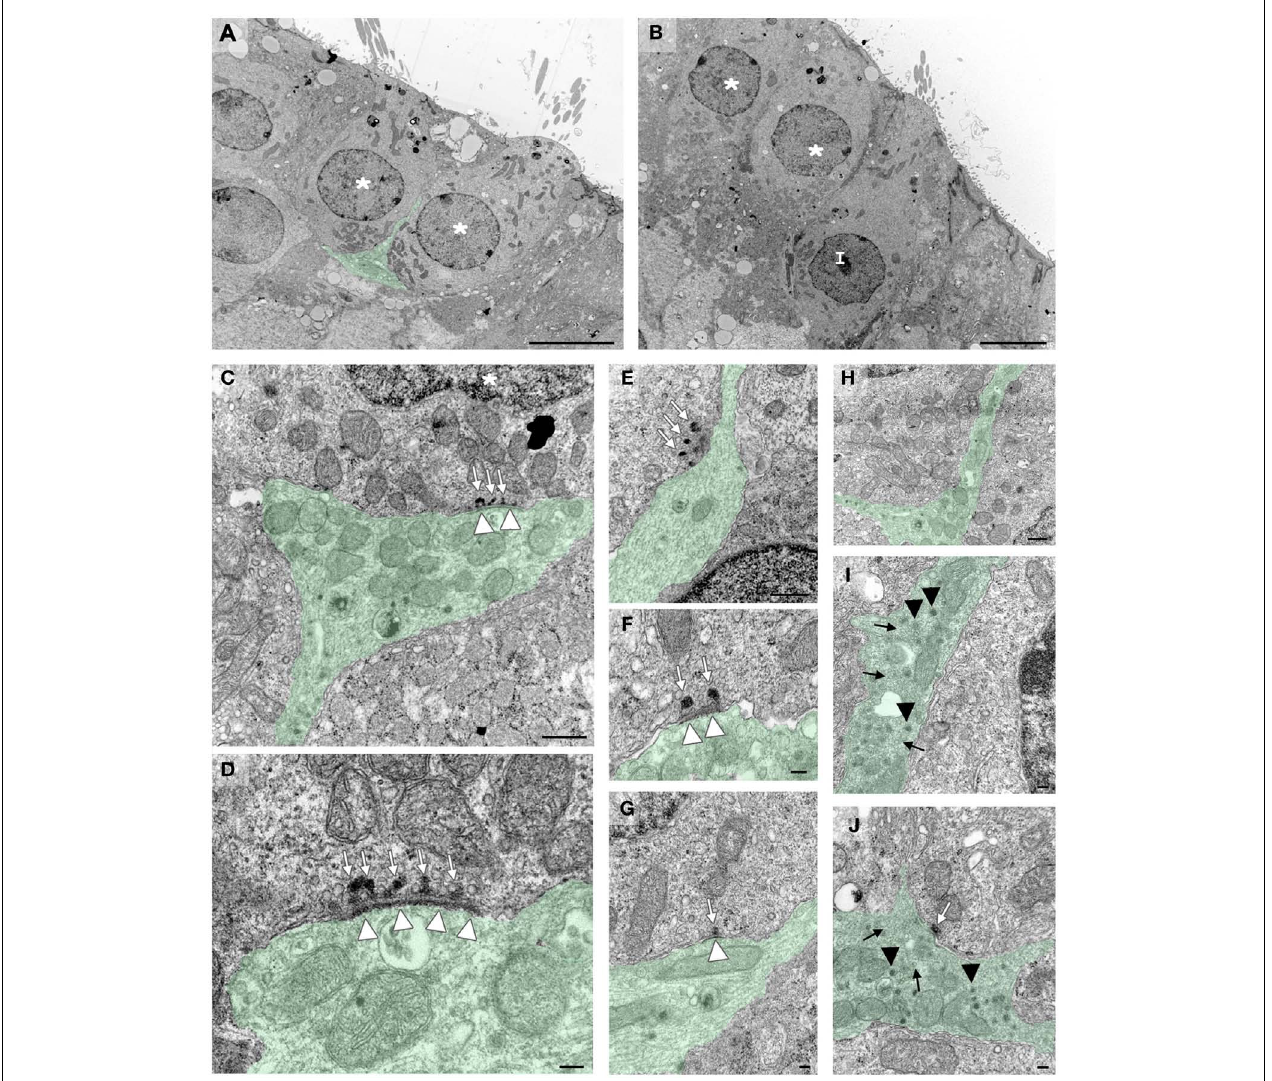
calyceal terminals. Fibers climb along the hair cell membrane facing ribbons (E–G) , presenting some post-synaptic densities (F,G) . Contacts with multiple (E,F) or single (G) ribbons were found. In these growing afferent fibers (H–J) , typical small synaptic vesicles of immature calyceal innervations were observed in the newly formed terminals (black arrows) (I,J) . Large granular vesicles (black arrow head) typical of peptidergic synaptic vesicles were